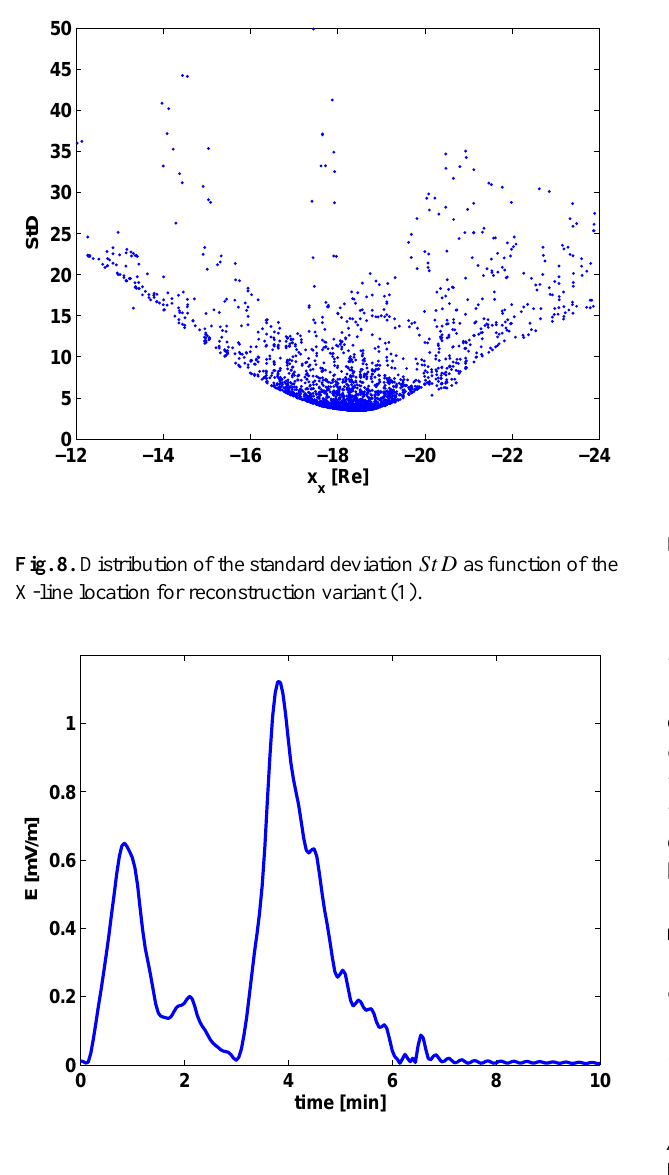
Fig. 9. Reconstructed electric field E(t) .